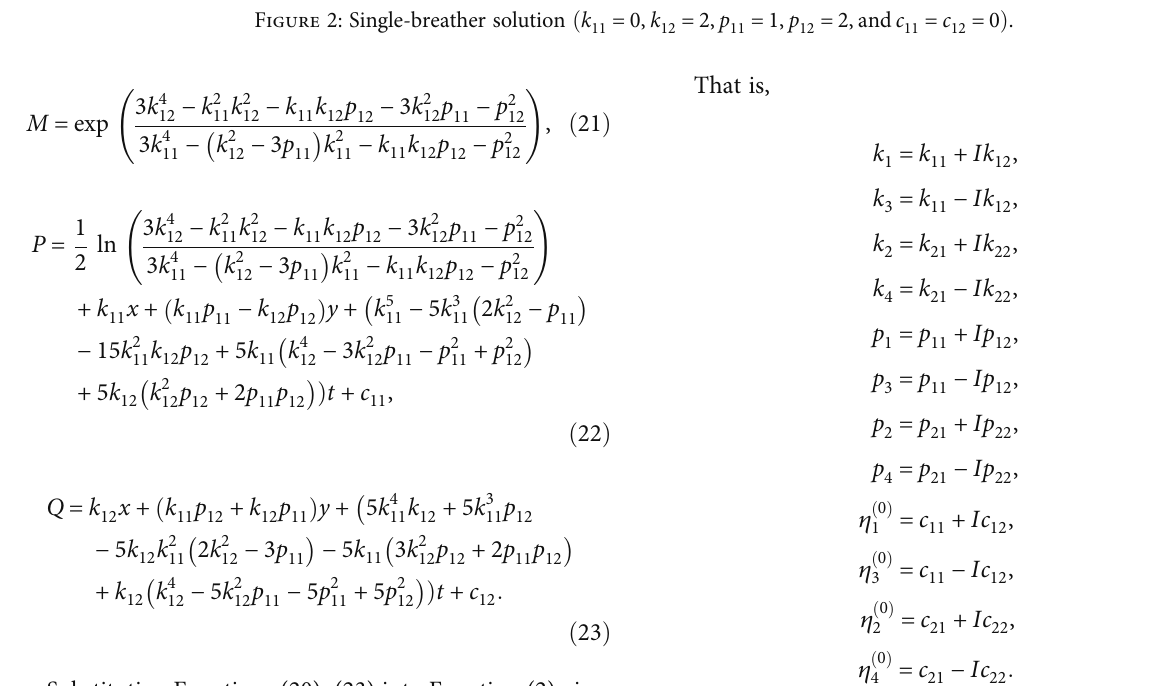
Figure 2: Single-breather solution ð k